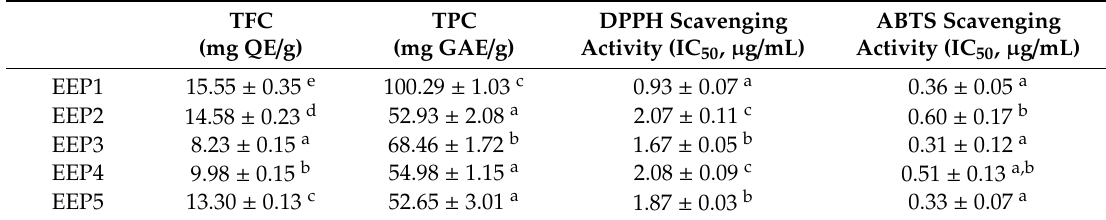
Table 3. The results of total flavonoid content (TFC), total polyphenols content (TPC) and antioxidant activity analyses in vitro (DPPH,